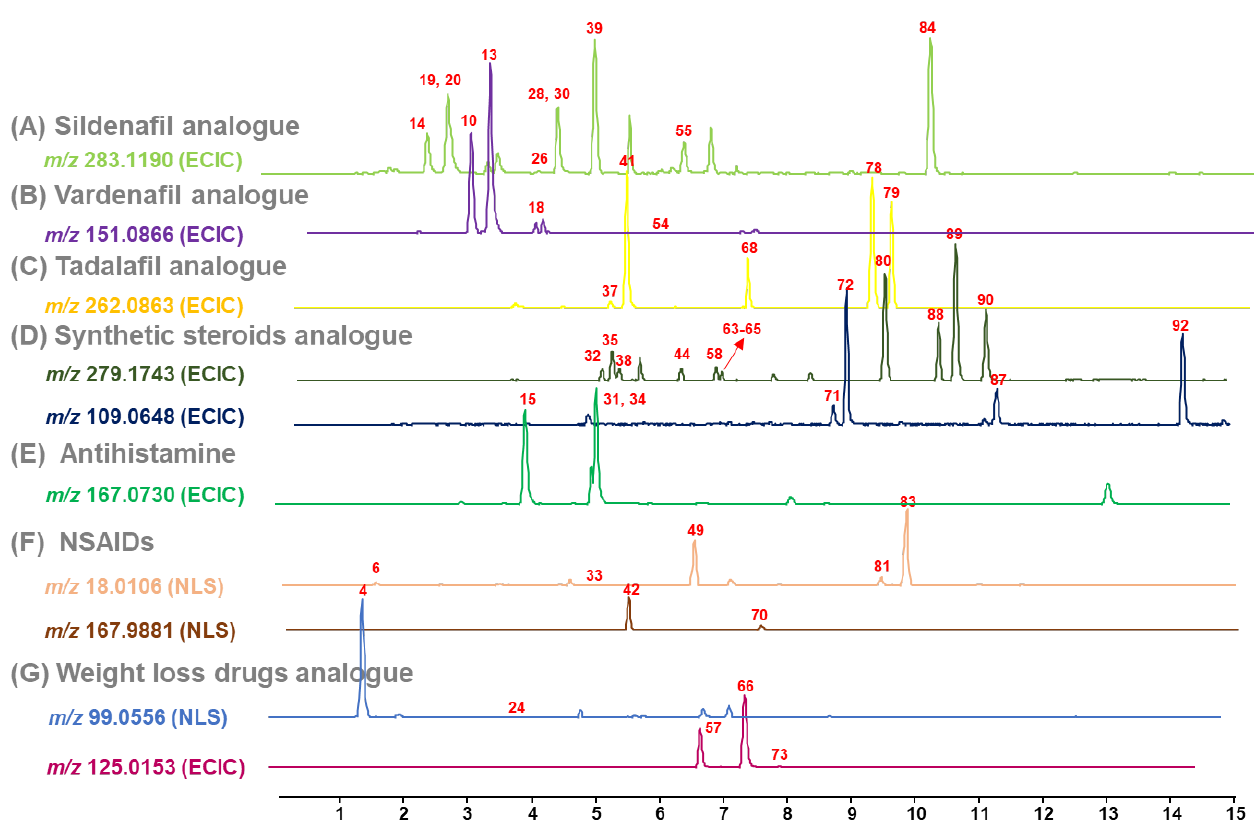
Figure 5. ECICs and NLSs of illegal adulterants after application of EMR-Lipid dSPE pretreatment to soft-gel samples spiked with analytes at 2 μg/ g level.